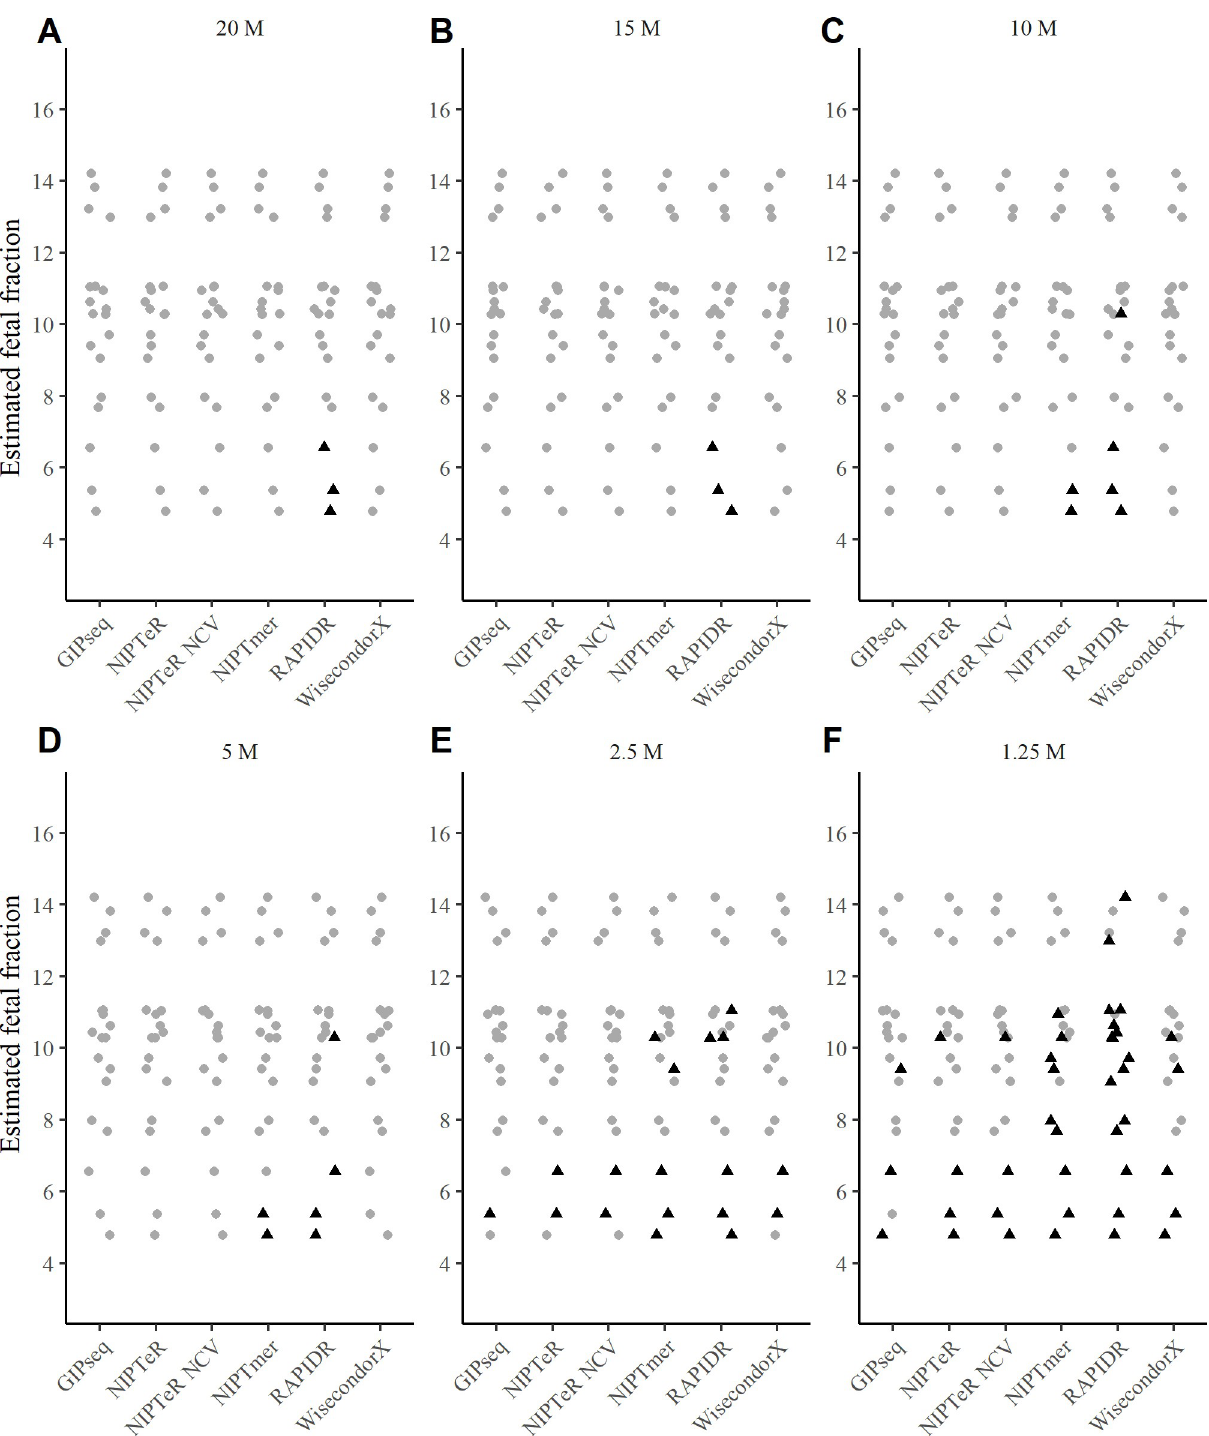
Fig 4. The effect of FF on detection of T21 across different sequencing coverages. Z (internal classification in the case of GIPseq). Black triangles represent undetected trisomy cases. The 20M RPS group served as the standard for FF calculations. Data obtained with sequencing depths of 20M RPS (A), 15M RPS (B), 10M RPS (C), 5M RPS (D), 2.5M RPS (E), and 1.25M RPS (F) are shown.